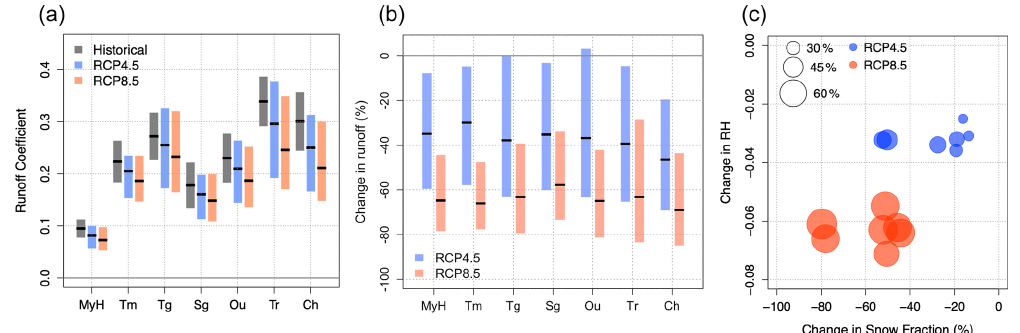
Figure 13. (a) Average runoff coefficients for the seven catchments in the observations (black) and projected average values in the RCP4.5 (blue) and RCP8.5 (red) scenarios. Boxes represent 90% confidence intervals. (b) Projected relative changes in runoff across the seven catchments against relative change in snow fraction ( x axis) and change in catchment-wide relative humidity ( y axis), for the RCP4.5 (blue) and RCP8.5 (red)